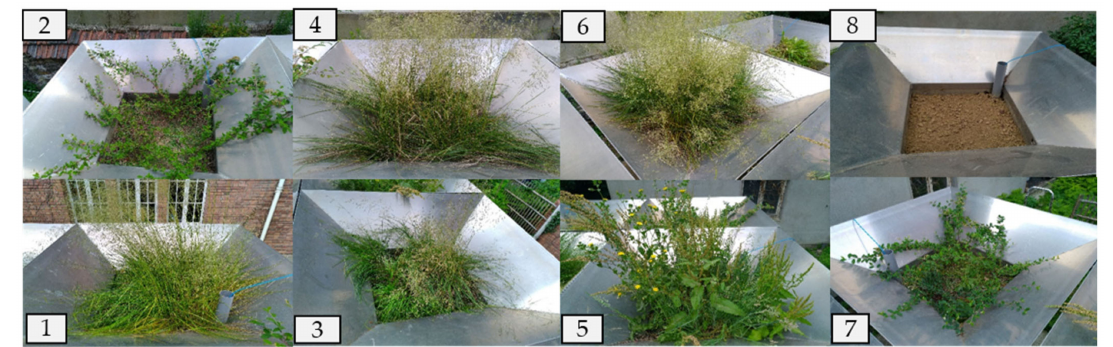
Figure A1. The vegetation in the eight lysimeters on 21 June 2018 (Source: DPE-STEA, Paris council). It can be observed that the spontaneous vegetation (lysimeter 5) is more developed compared to the other settings and that today the vegetation in lysimeter 8 has been removed. Moreover, the shrub configurations (2,7) are not well developed compared to the other